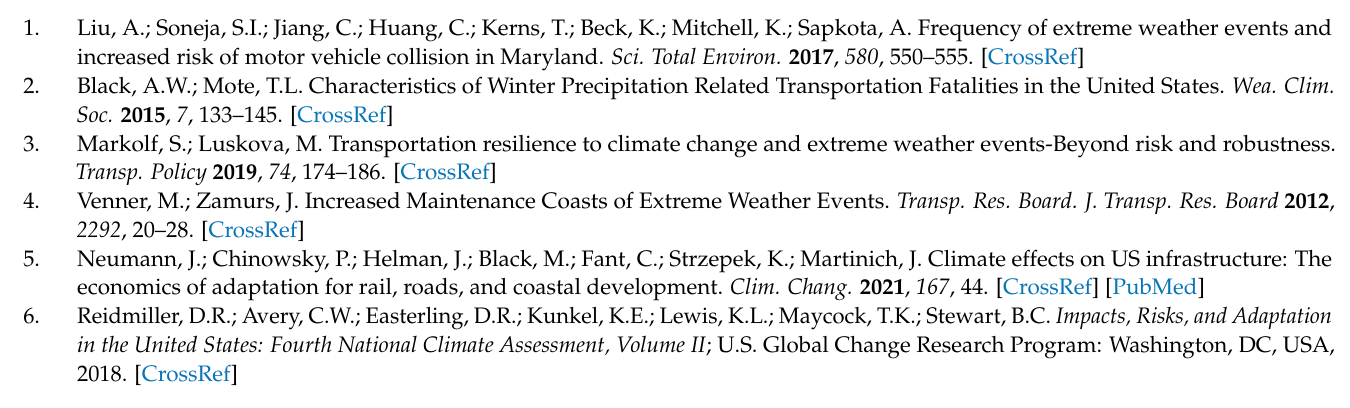
Figure A3. Average response on a Likert scale (1 = strongly disagree, 3 = neutral, 5 = strongly agree) from survey respondents’ regarding their perceptions of barriers to using climate data (inclusive of historical and future data). Responses include those who exited the full survey early (green, left, n = 7), and those who completed the full survey (red, right, average n = 27). The level of agreement between the two categories differs notably for some aspects of this query (e.g., those who do plan to use climate data also show it to not be a priority). Respondents in both categories, however, agreed with statements such as: “I need more, or different variables from ones provided by most climate datasets” and “spacing between data-points is insufficient to generate decision-relevant guidance.” While addressing these limitations was beyond the project scope, it may be useful to readers to consider some of the problems with the uptake of climate data as mentioned by these stakeholders.